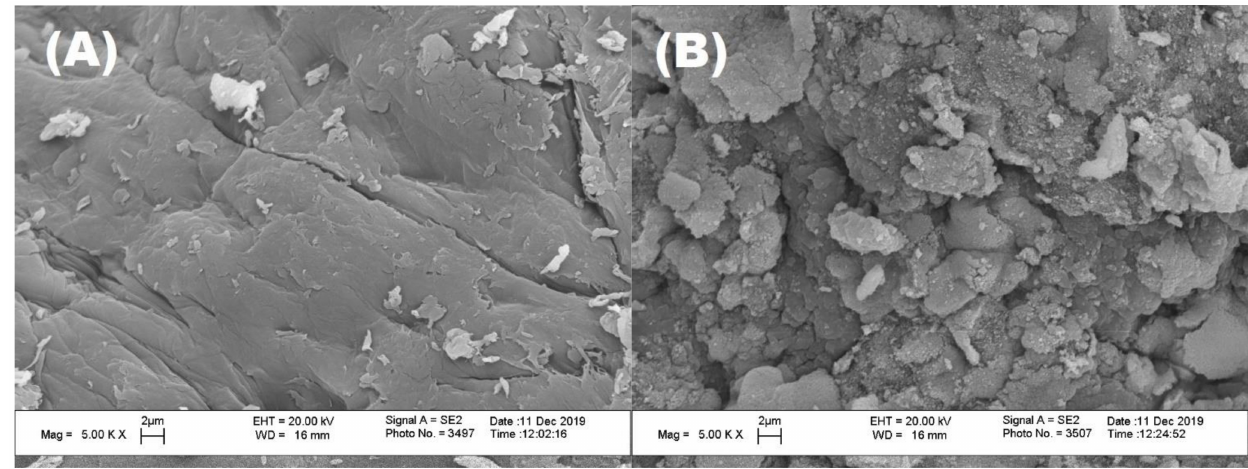
Figure 4. FESEM of chitosan ( A ), and the chitosan–CaO nanocomposite (15 wt%) ( B